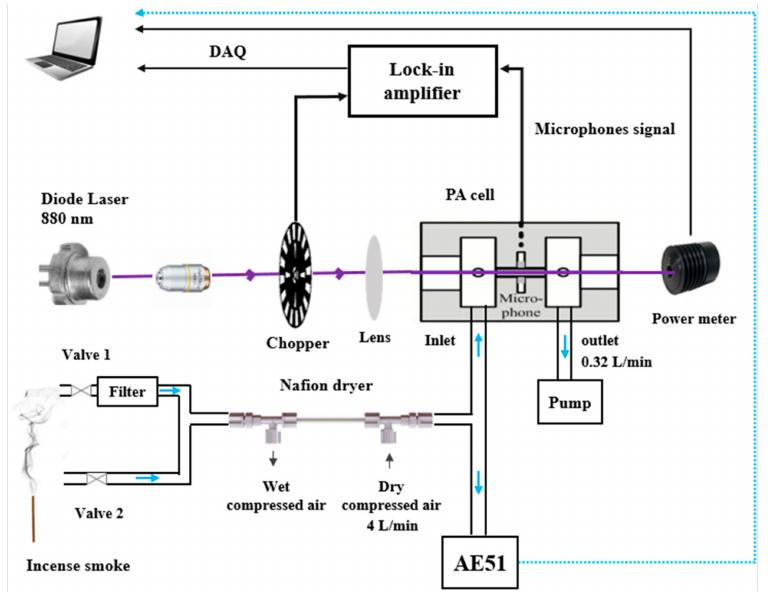
Figure 5. Schematic of the experimental setup for the measurement of incense generated BC with the PASS instrument and the reference aethalometer